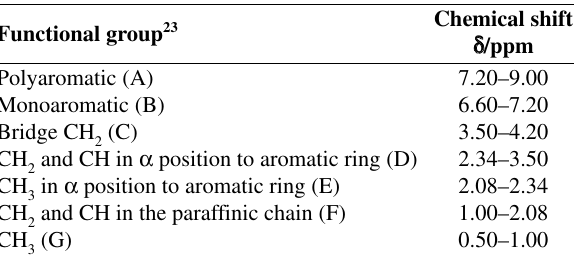
Table 1. Characteristic functional groups and 1 H NMR chemical shift ranges.